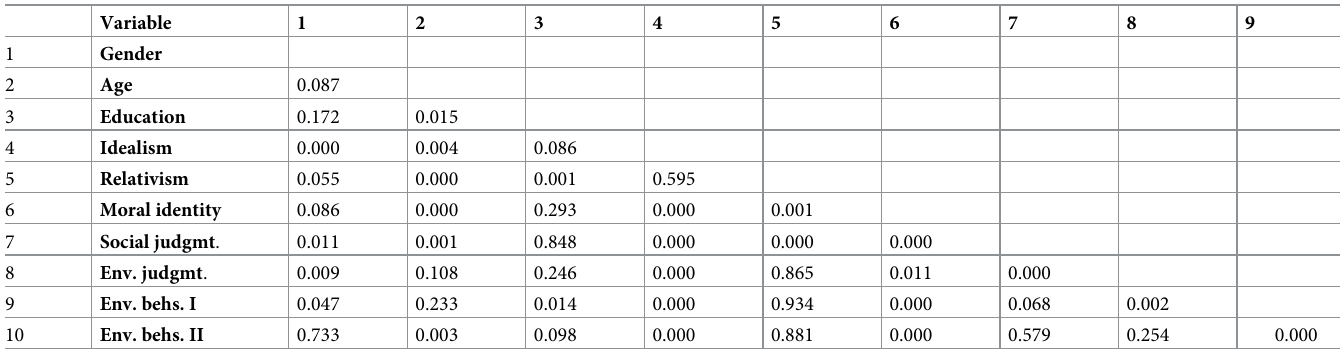
Table 5. P values of intercorrelations among study variables.